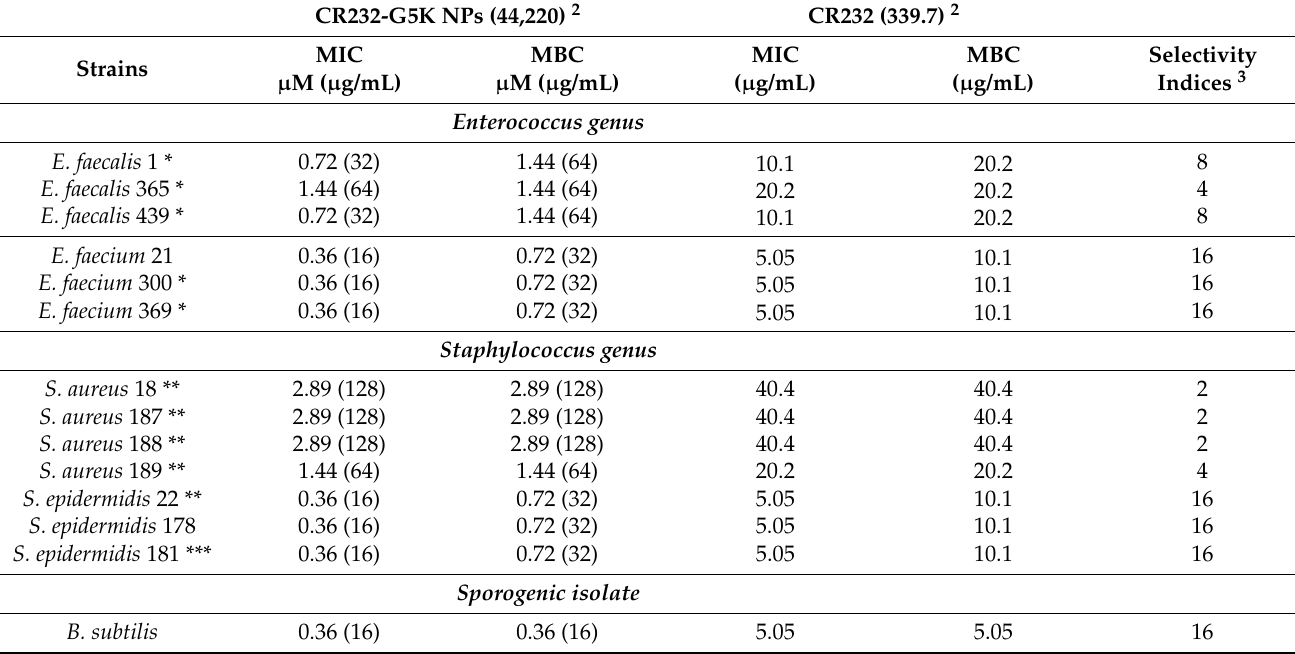
Table 2. MICs and MBCs of CR232-G5K NPs against bacteria of Gram-positive species, obtained from experiments carried out in triplicate 1 , expressed as µ M and µ g/mL, and those of CR232 released according to the DL% and the release profile of CR232-G5K NPs [20], expressed as µ